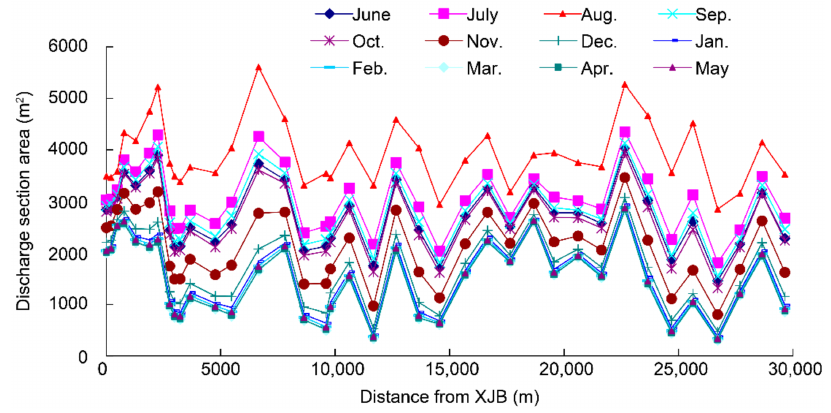
Figure 5. Discharge section area for each month during typical dry years in the study area.